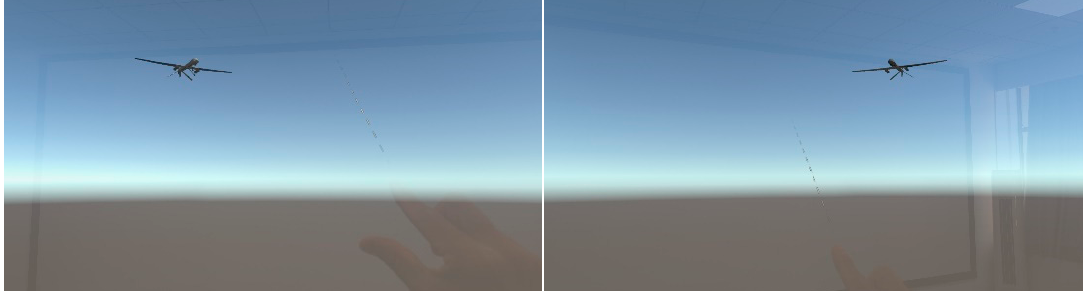
Figure 7. Range of distance field of view in MR.